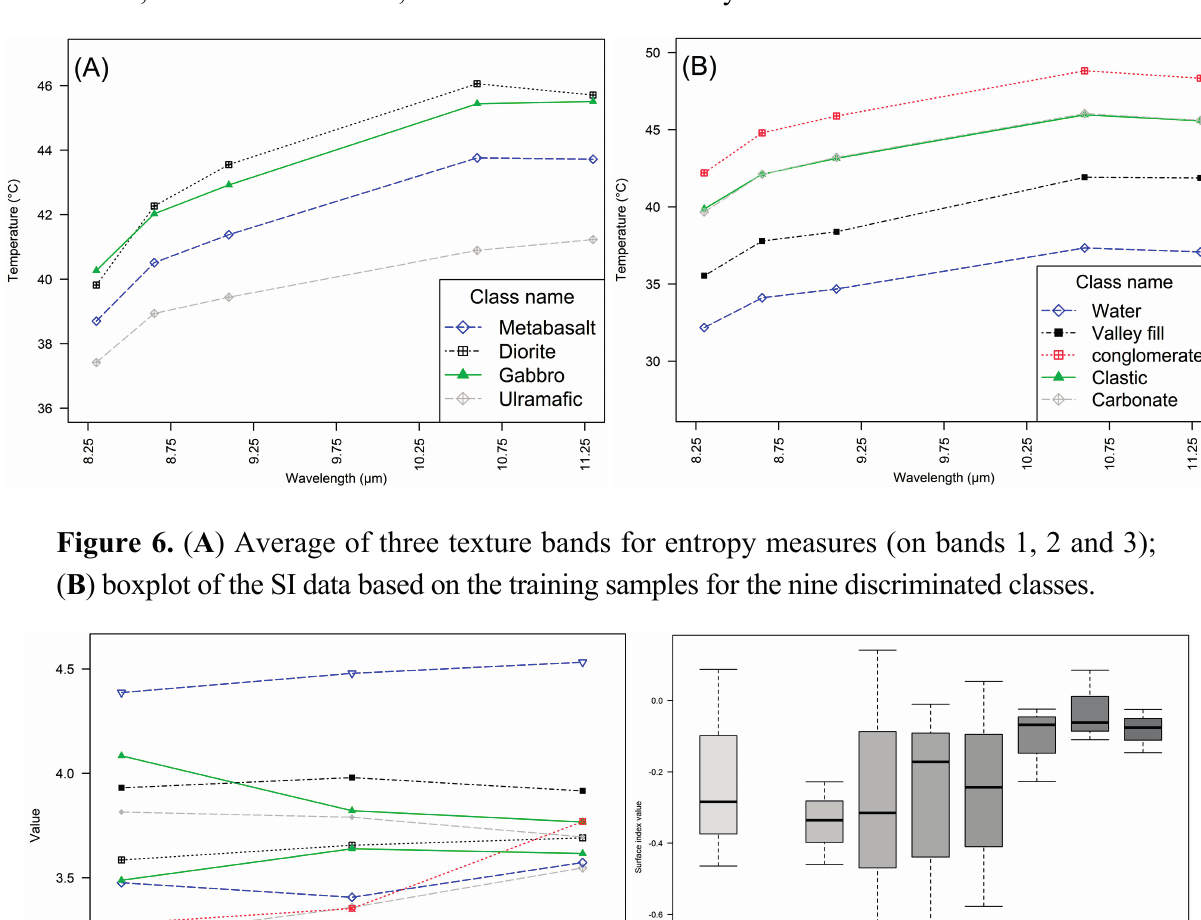
Figure 5. Average of at-sensor temperature based on training samples selected from ASTER data acquired on 24 August 2003 for ( A ) for igneous rocks classes and ( B ) five classes, which include water, sediments and sedimentary rocks.